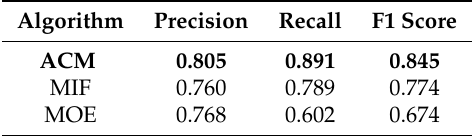
Table 3. Performance of the arrhythmia-classification module (ACM), the classification system based on morphology and interval features (MIF), and the classifier using a mixture of experts (MOE) in terms of average precision, average recall, and average F1